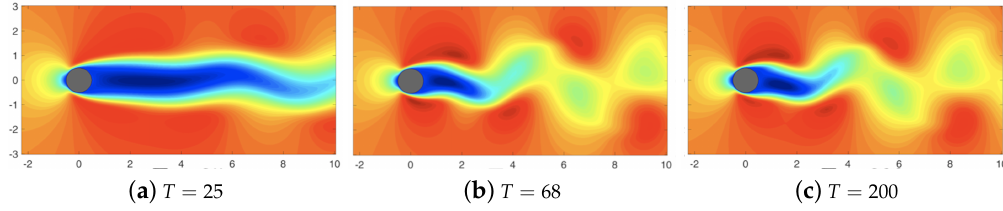
Figure 3. Isocontour plots of the stream-wise velocity component for the cylinder flow at Re = 100 at T = 25,68,200, showing the evolution of the flow field. Here, T represents the time non-dimensionalized by the advection time-scale.